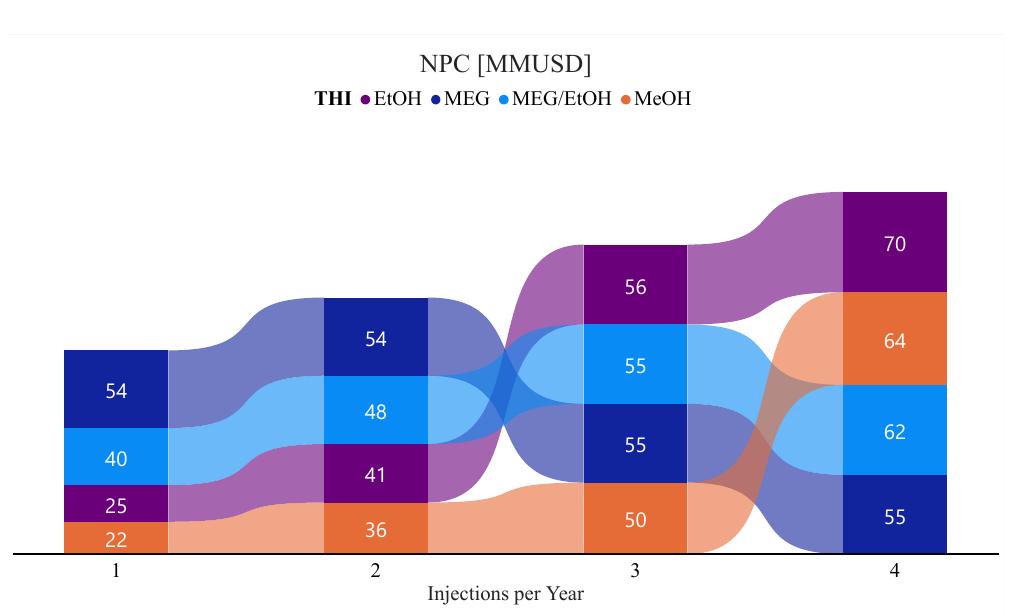
Figure 8. Net present cost for each THI as function of frequency of injections per year.